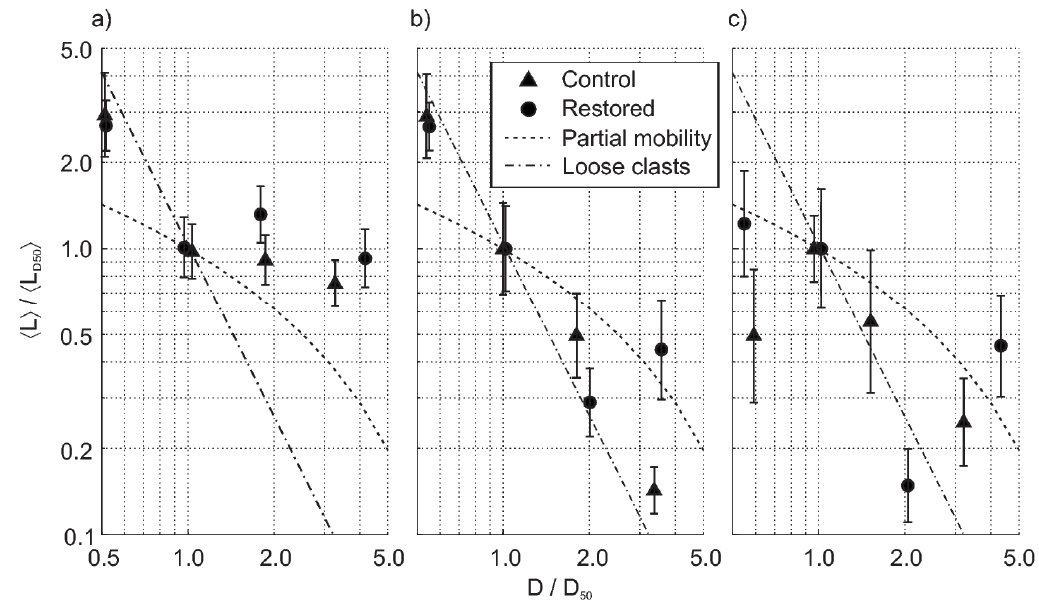
Figure 10. Travel distances in control and restored reaches for ( a ) August 2013–May 2014; ( b ) May 2014–July 2014; and ( c ) July 2014–August 2014. Lines representing partial mobility (Equation (8)) and transport of loose unconstrained clasts (Equation (9)) are shown for